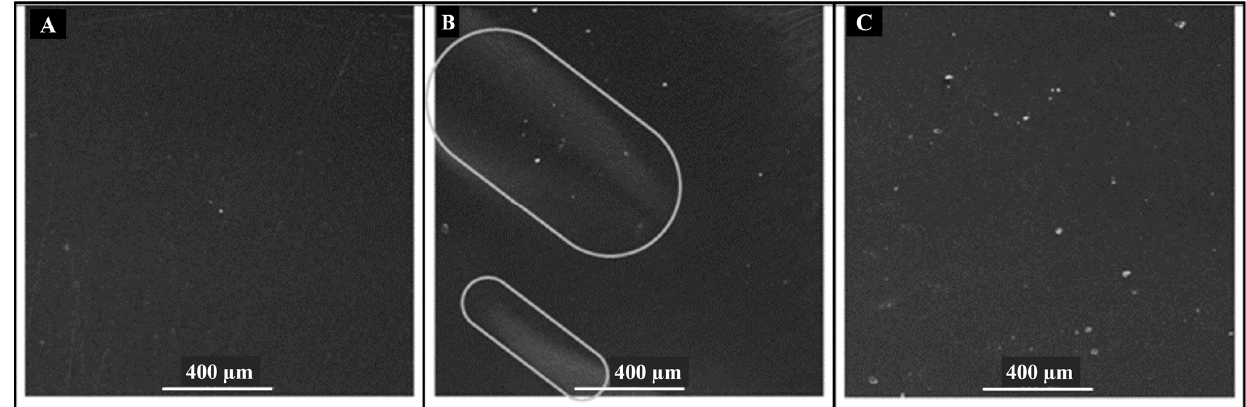
Figure 5. SEM micrographs PLASiOx-PLA films: ( A ) Untreated film, ( B ) HPP treatment at 500 MPa and 50 °C for 15 min, in contact with water as food simulant, and ( C ) HPP treatment at 500 MPa and 50 °C for 15 min, in contact with olive oil as food simulant, Reprinted with permission from Ref. [12], Copyright (2022) Elsevier.